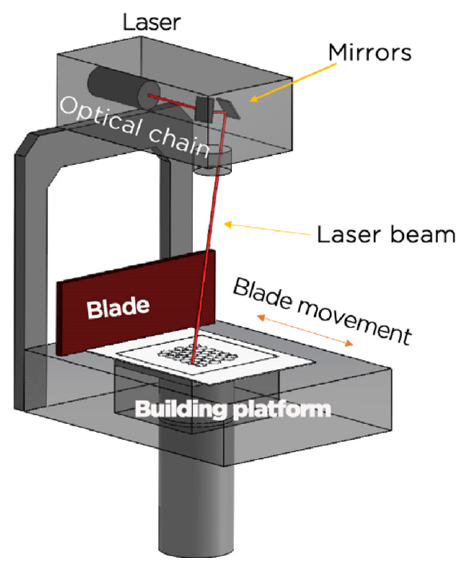
Figure 1. Schematic illustrations of the SLA apparatus (courtesy of 3Dceram).